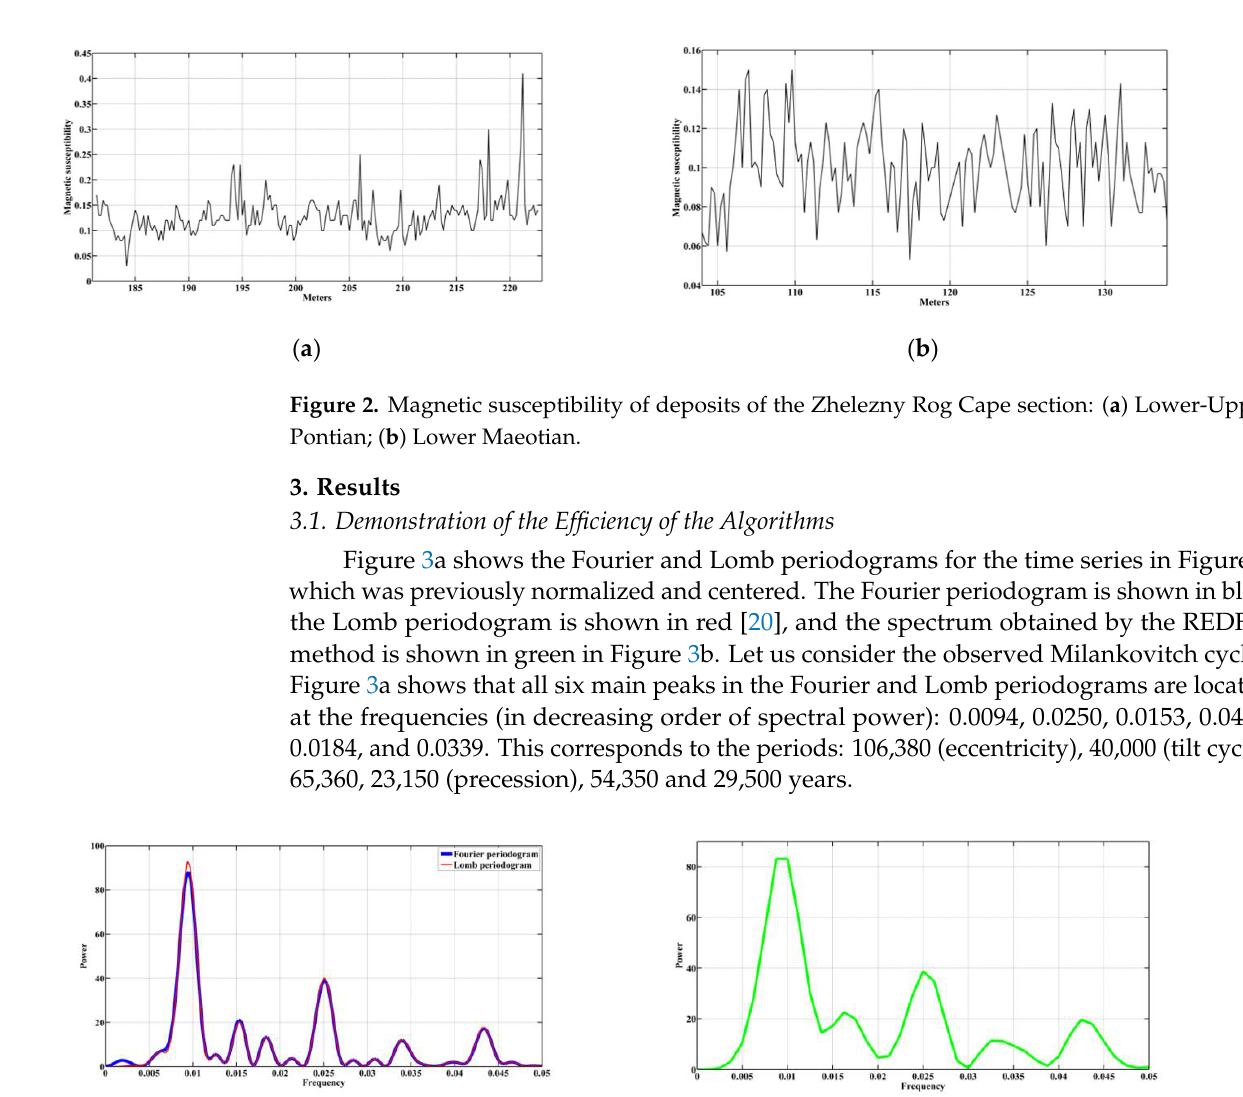
Figure 4. Function constancy exponent (construction—variance) and determination of periods. 3.2. Identification of Periods in Magnetic Susceptibility Data Figure 5 shows the results of applying spectral methods to the magnetic susceptibil- ity data for the Pontian deposits (Figure 2a) of the Zhelezny Rog Cape. Of the three prom- inent peaks on the Lomb periodogram, two peaks fall within the 95% confidence interval (Figure 5a). These peaks are located at frequencies of 0.0425 and 0.2519, corresponding to periods of 23.53 m and 3.97 m, respectively. This result is confirmed by the Fourier peri- odogram (Figure 5a), where the main peaks are located at frequencies of 0.0437 and 0.2519 periods of 22.88 m and 3.97 m. In contrast to the example described above (Figure 3a), the Fourier and Lomb periodograms in Figure 5a differ slightly. These differences can be ex- plained by white noise in the original data (Figure 2a).